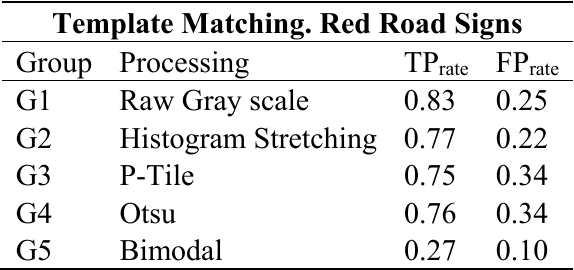
Table 1. Results on recognition of red road signs regarding the processing applied to the candidate.